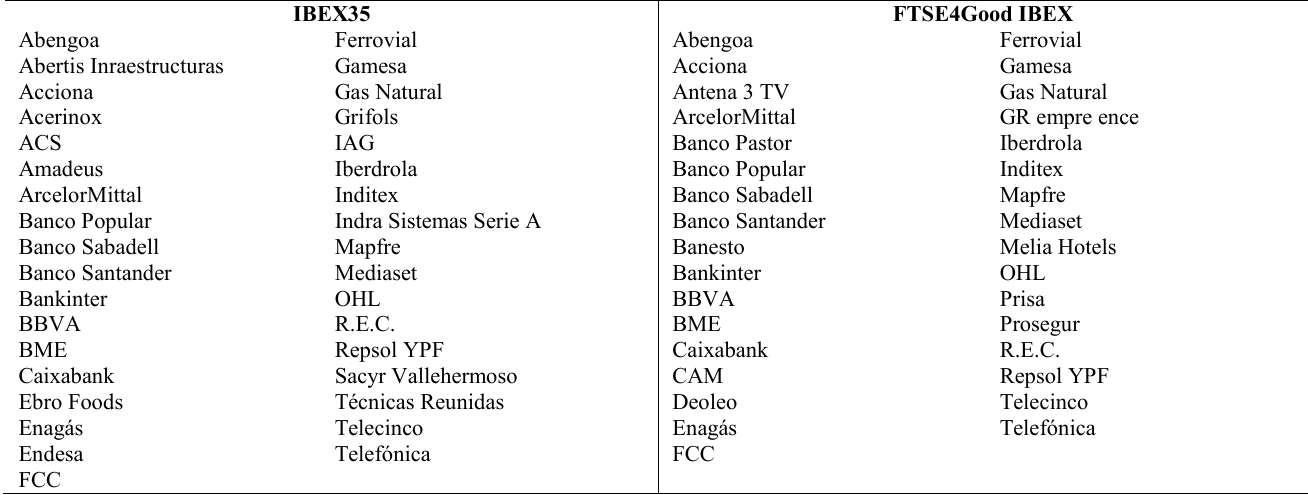
Table 1: Business stocks included in the IBEX35 and FTSE4Good IBEX indexes